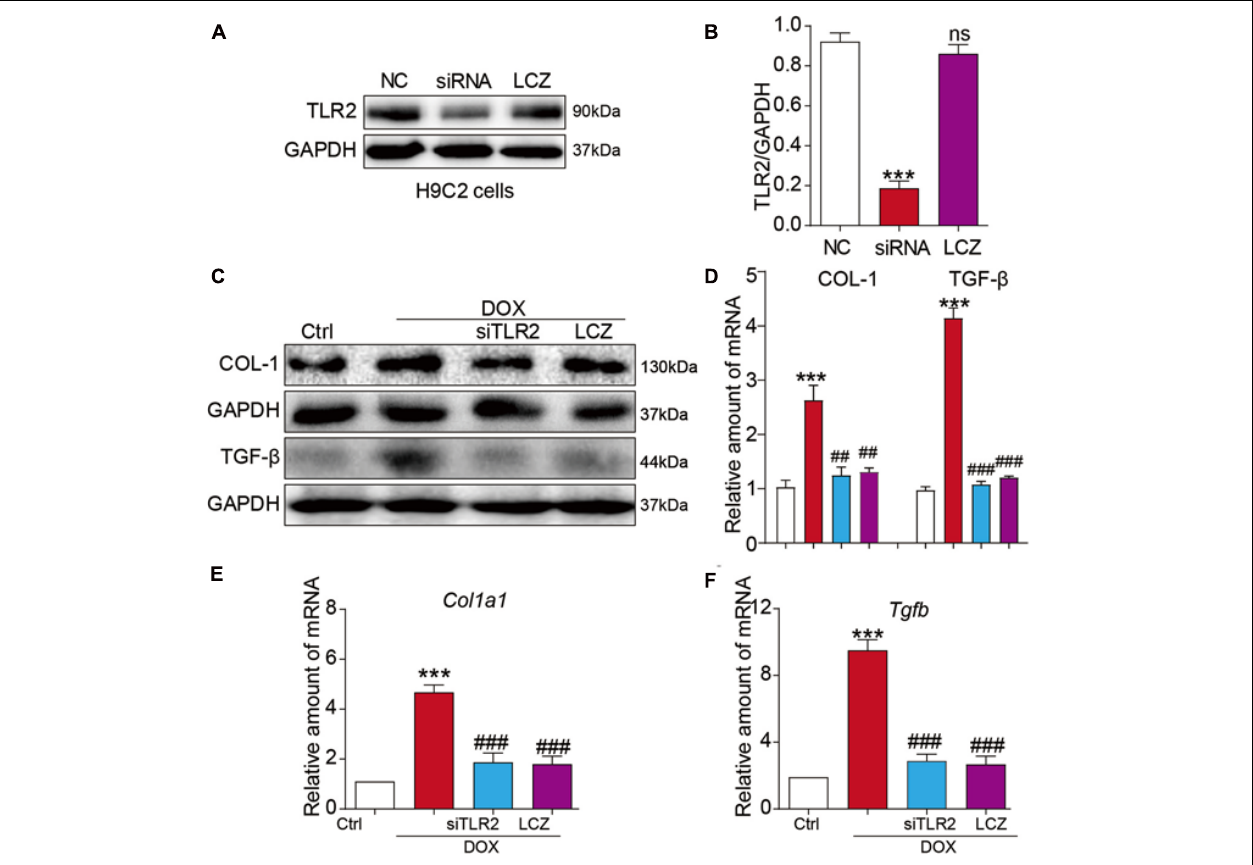
FIGURE 4 | LCZ696 treatment and TLR2 knockdown attenuated doxorubicin-induced H9C2 cell fibrosis in vitro . (A) H9C2 cells were transfected with control siRNA (NC) or TLR2 siRNA (siTLR2) and treated with LCZ696 (20 µ mol/l) for 24 h. Western blot detected TLR2 and GAPDH protein levels. (B) Densitometric quantification of TLR2/GAPDH levels in the immunoblots presented in panel (A) . (C) H9C2 cells were transfected with control siRNA or TLR2 siRNA and pre-treated with LCZ696 (20 µ mol/l) and then stimulated with DOX (1 µ M) for 24 h. Western blot analysis of the protein levels of collagen I and TGF- β in whole cell lysates. (D) Densitometric quantification of collagen I/GAPDH and TGF- β /GAPDH levels in immunoblots presented in panel (C) . (E,F) The mRNA levels of Col1a1 (E) and Tgfb (F) were detected by real-time PCR. ( n = 5; *** P < 0.001 vs. Ctrl group; ## P < 0.01 compared to Ang II; ### P < 0.001 vs. DOX